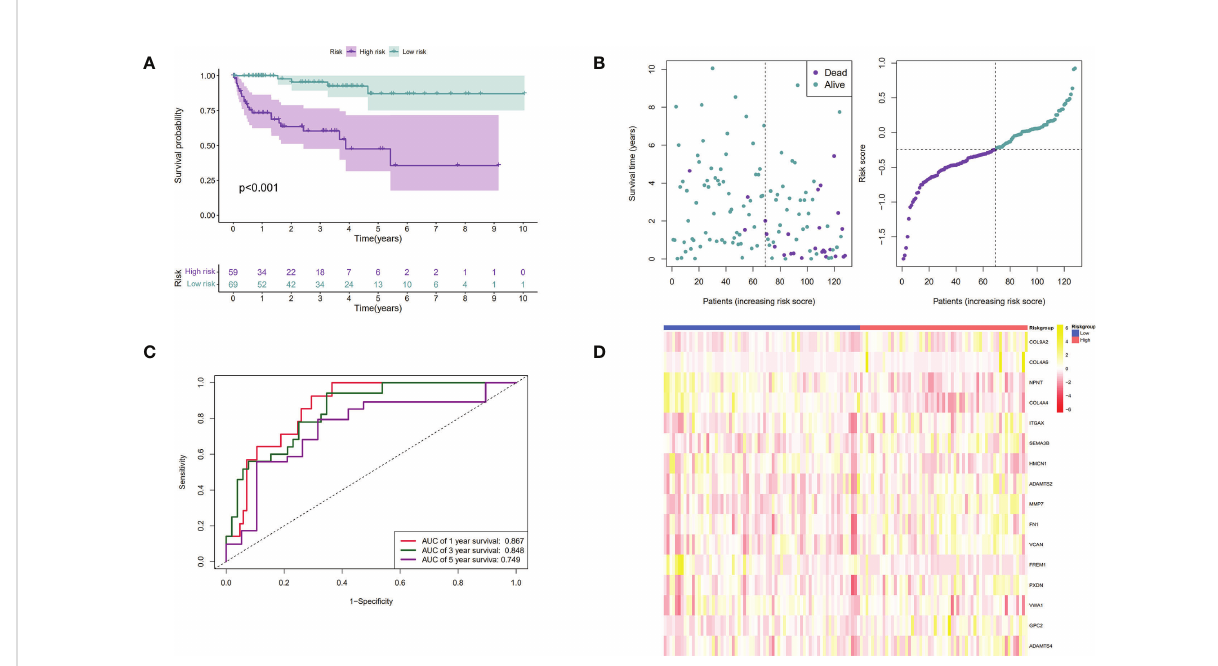
FIGURE 5 Veri fi cation of the prognostic signature by utilizing the GEO dataset. (A). The Kaplan-Meier curves of low-risk and high-risk ccRCC patients in the GEO dataset; (B). The time-dependent ROC curves displaying the 1-year, 3-year, and 5-year OS of ccRCC patients in the GEO dataset; (C). Survival distributions of the GEO dataset determined according to the median risk score; (D). Heatmap displaying the divergences between low and high-risk patients of 16 signature genes in the prognostic model for the GEO